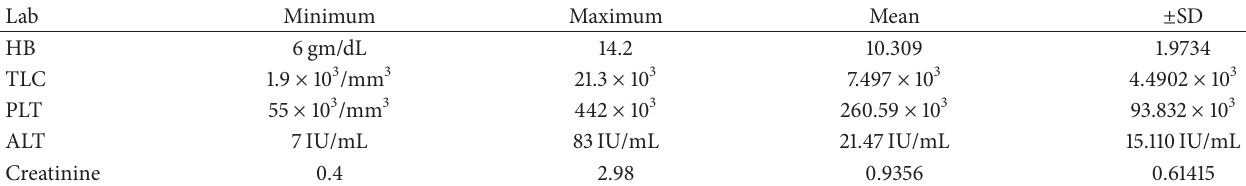
Table 2: Showing laboratory data of SLE patients.